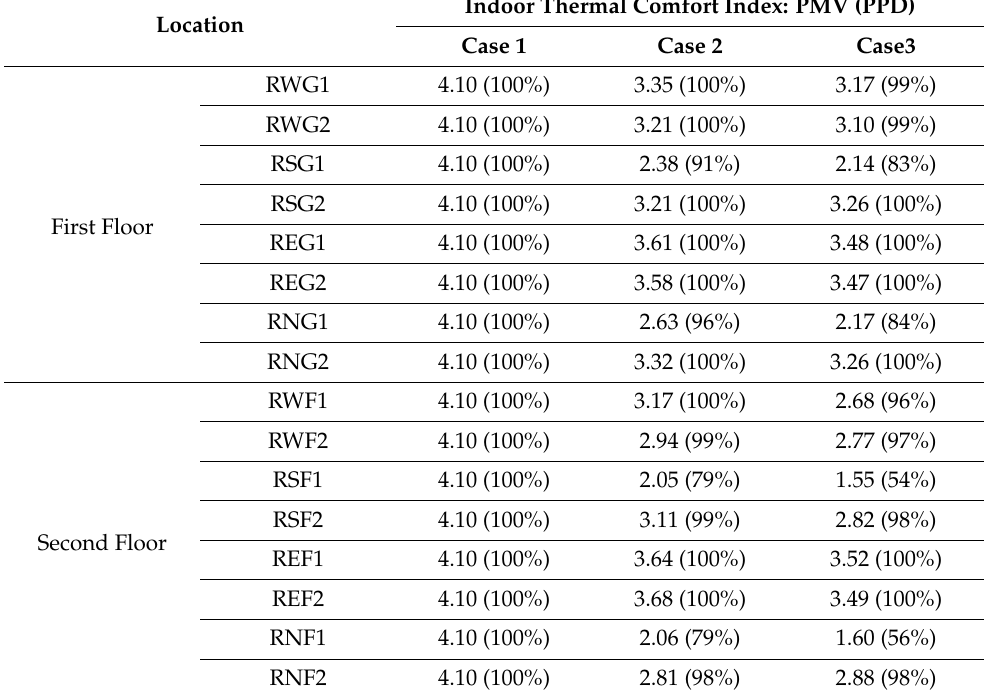
Table 4. Indoor thermal comfort index in each